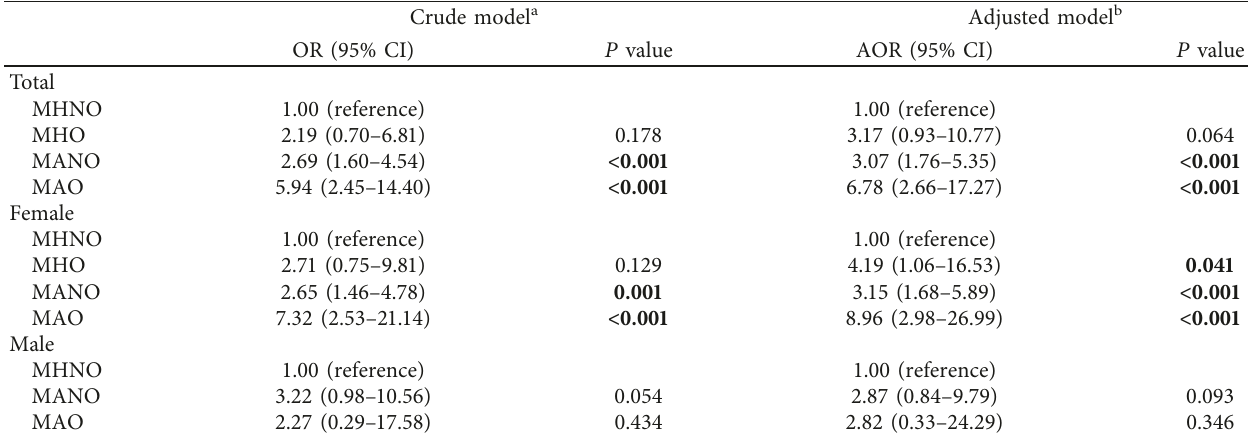
Figure 2: Prevalence (a) and relative expression (b) of reduced eGFR (eGFR < 90) among the various obese Table 3: Association between reduced eGFR and obese phenotype in different genders.